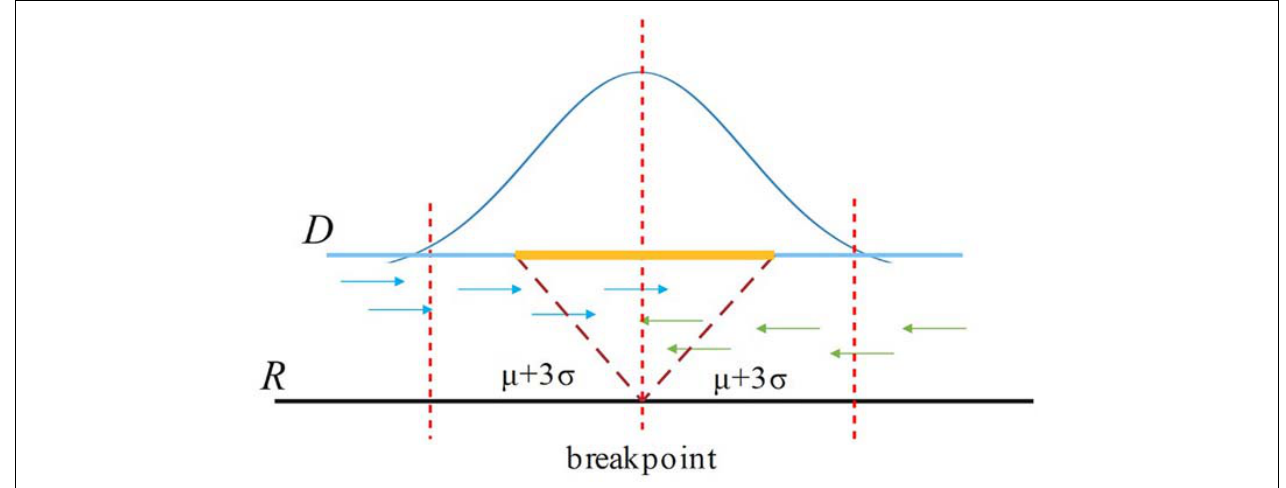
FIGURE 3 | For a breakpoint, SIns only consider reads aligned in the region [p – ( µ +3 σ ), p + ( µ +3 σ )], where p is the position of the breakpoint.